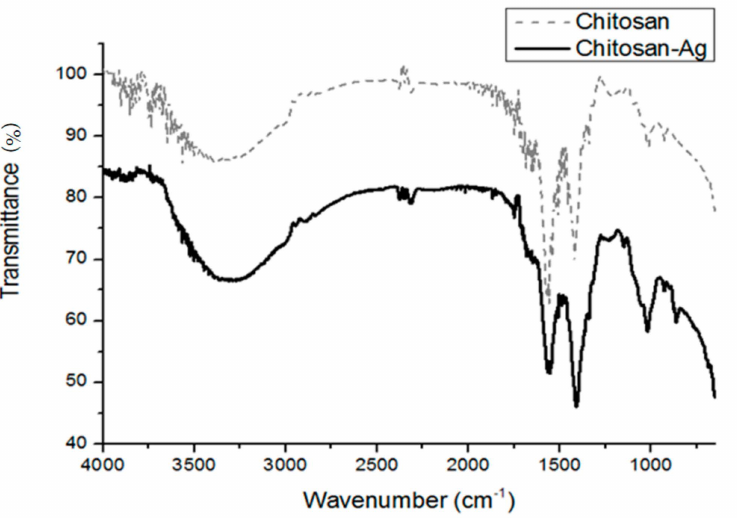
Figure 7. FTIR spectra of pure chitosan and chitosan/Ag